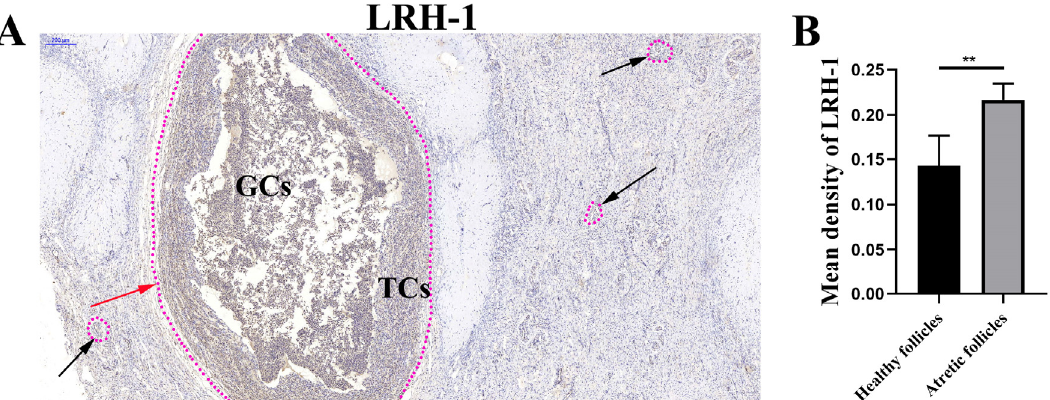
Figure 1. LRH-1 high expression in the atretic follicles. ( A ) Immunochemistry assay was performed to visualize the localization of LRH-1 in bovine ovarian cells. Immuno-specific staining was brown, indicating LRH-1-positive cells. Immunohistochemistry was performed on three different ovarian slides from each of three bovines. Atretic follicles were indicated with the red arrow, whereas healthy follicles were indicated with black arrows. Bar: 200 μ m. ( B ) The LRH-1 levels of granulosa cells in atretic follicles or healthy follicles. Data are shown as the means ± SEM of three biological replicates. ** p < 0.01, comparing the indicated groups. TCs, theca cells; GCs, granulosa cells.